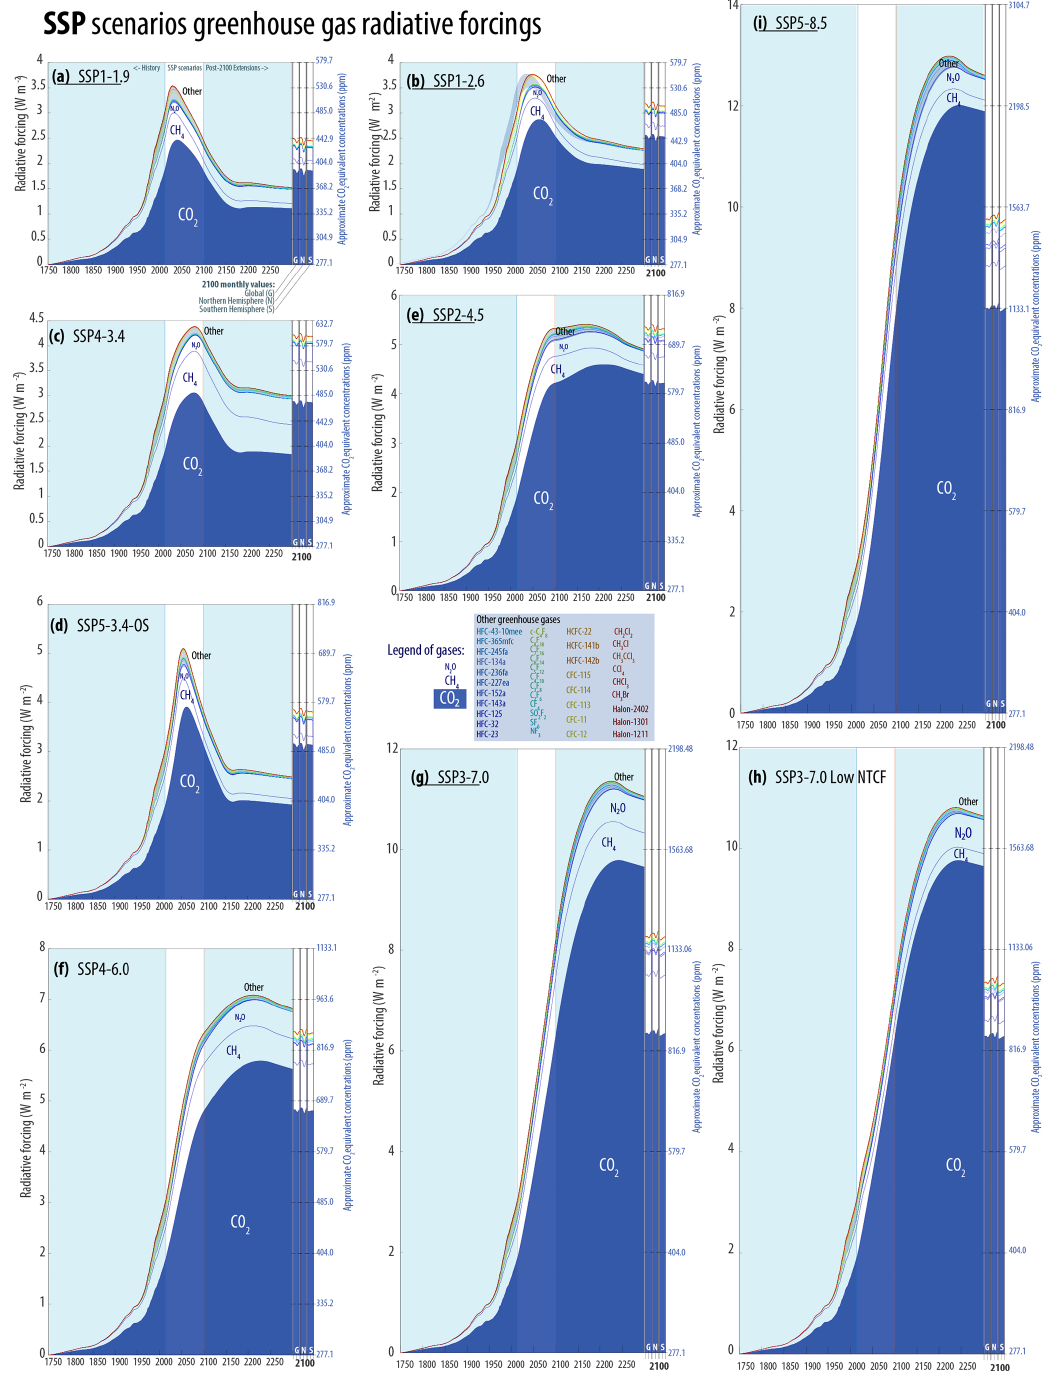
Figure 7. Overview of all greenhouse gases within SSP scenarios and their relative importance in terms of radiative forcing. The radiative forcing contributions are stacked, starting with CO 2 (blue shaded area) at the bottom, followed by methane (CH 4 ), nitrous oxide (N 2 O), and the other 40 greenhouse gases. Default radiative forcing efficiencies or parameterizations are used, with CO 2 , CH 4 , and N 2 O being based on a parameterization of the Oslo Line-By-Line model (Sect. 2.7). Seasonal and latitudinal variation is indicated by the three bars on the right of each panel for the global average, northern hemispheric, and southern hemispheric monthly mean concentrations for the year 2100. The light-blue shaded areas on the left side of each panel from 1750 to 2014 are based on historical greenhouse gas observations; the 21st-century span from 2015 to 2100 (white area) and the extension until 2300 and beyond are based on the MAGICC7.0 model. For the IPCC AR6, the five scenarios SSP1-1.9 (a) , SSP1-2.6 (b) , SSP2-4.5 (d) , SSP3-7.0 (g) , and SSP5-8.5 (i) are chosen as key scenarios for knowledge integration across chapters and working